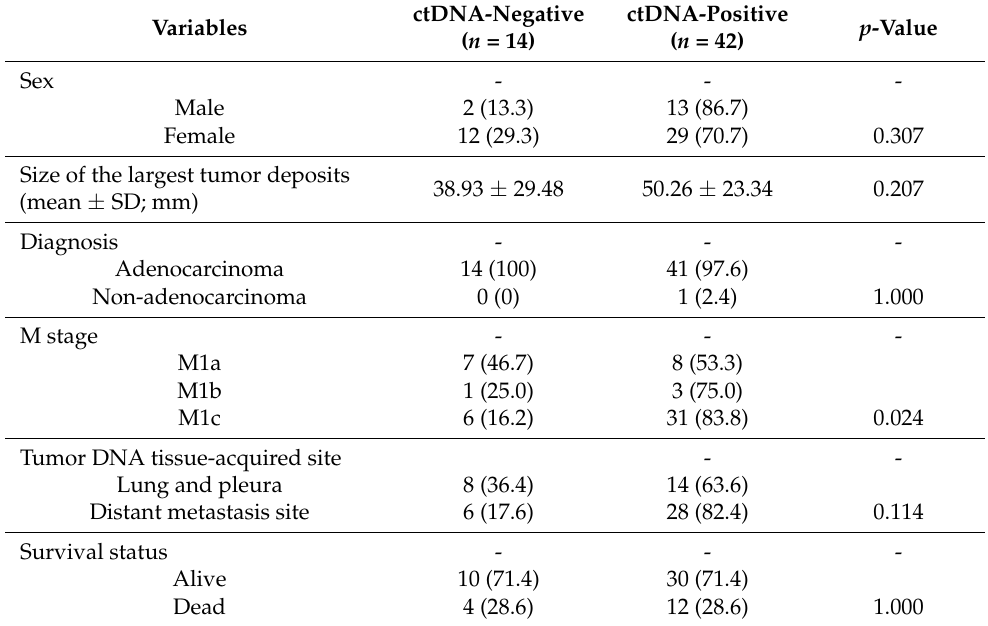
Table 6. Clinicopathological parameters of pre-treatment patients associated with ctDNA